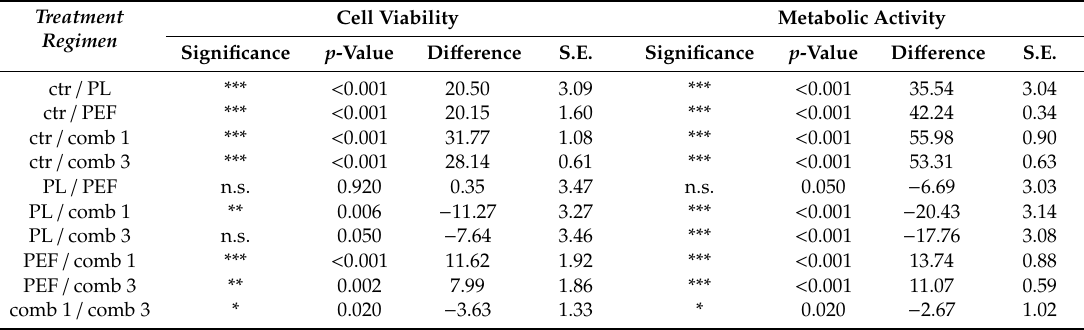
Table 5. Statistical analysis of cell viability and metabolic activity 24 h after treatment. A multiple t- test was performed (* p < 0.05; ** p < 0.01; and *** p < 0.001). ctr = control; PL = plasma; PEF = pulsed electric fields; comb = combination; n.s. = not significant.